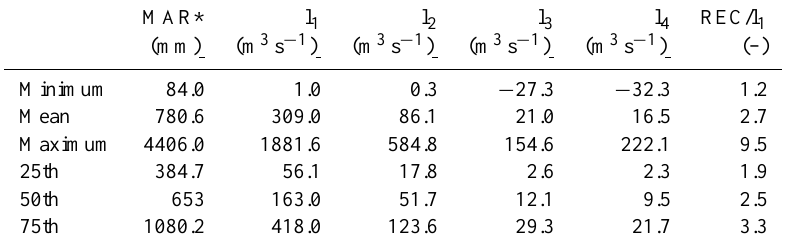
Table 2. Minimum, mean and maximum values, and 25th, 50th and 75th percentiles for the set of Y variables considered in the study. These data were either computed from the digital database of Italian AMS of flood flows compiled during the Italian VaPi (GNDCI-CNR) project or * retrieved from Rep. no 17 of the former Italian SIMN (National Hydrographic Service of Italy).